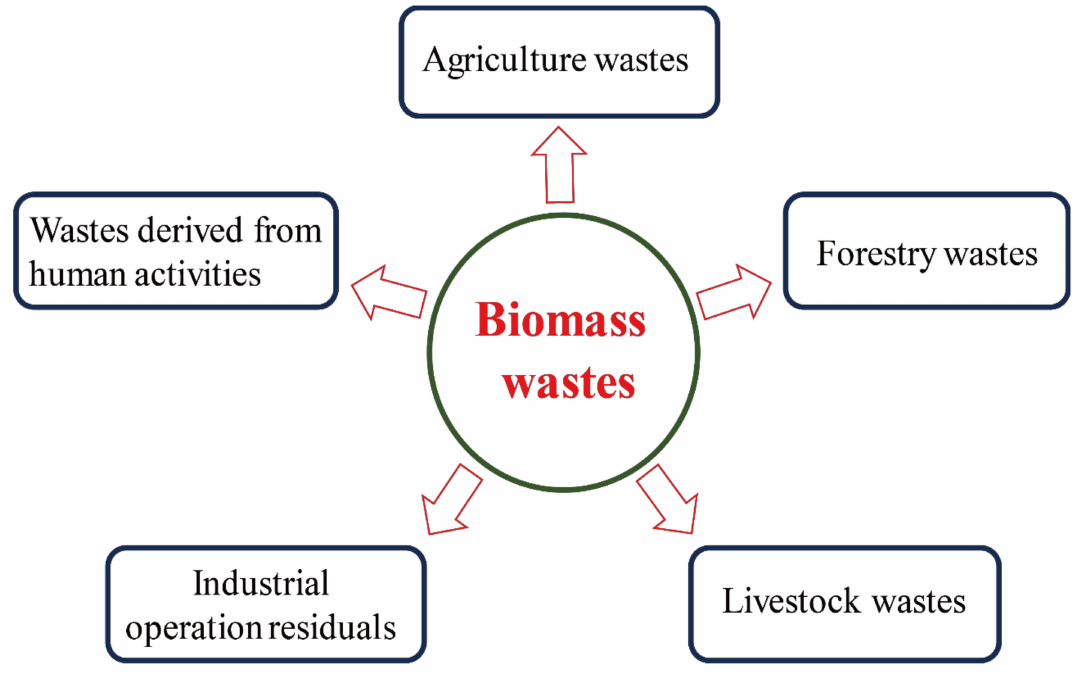
Figure 2. Main sources of biomass